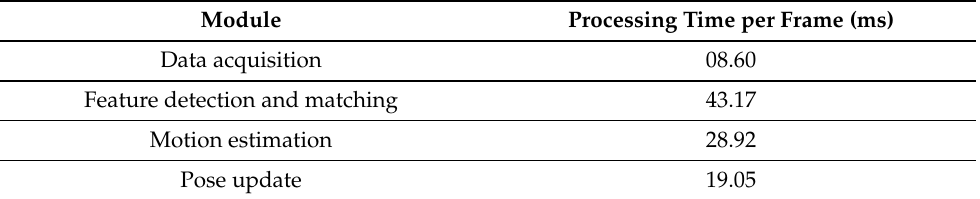
Table 4. Kinect processing time on an embedded computer (Kinect update rate is 10